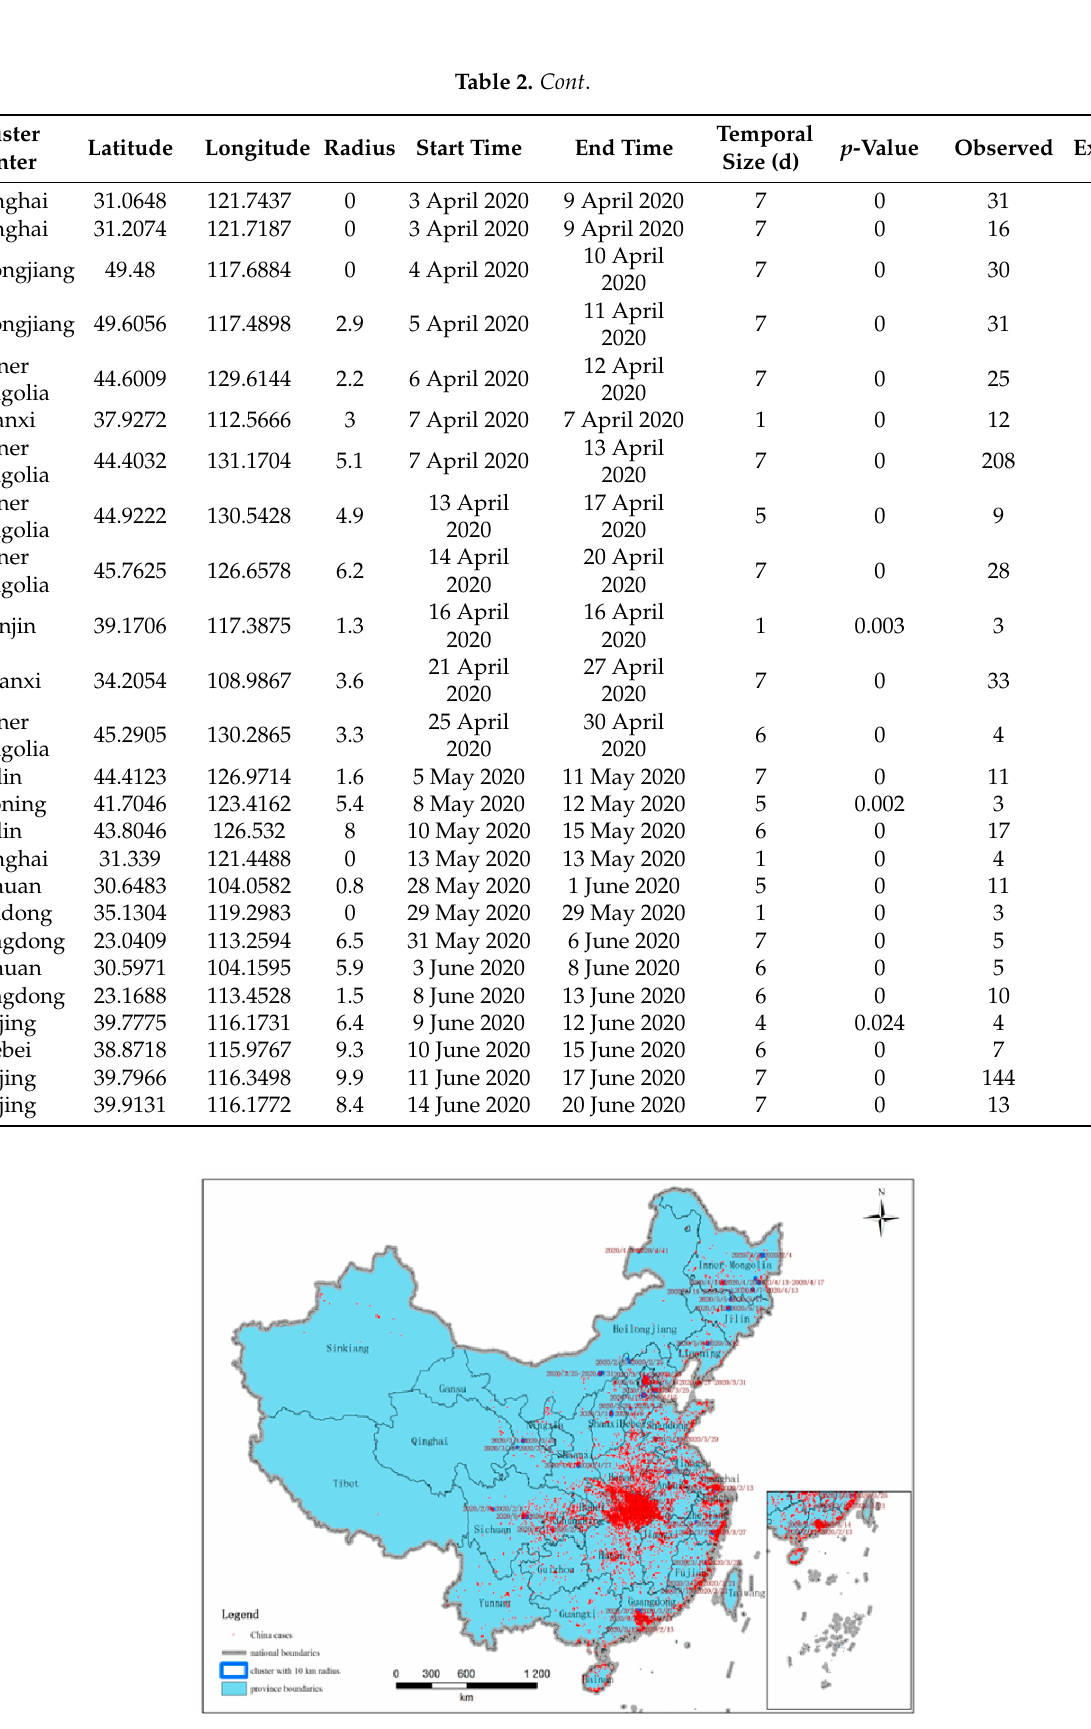
Figure 4. Space-time clusters of COVID-19 at the family-level with a maximum spatial